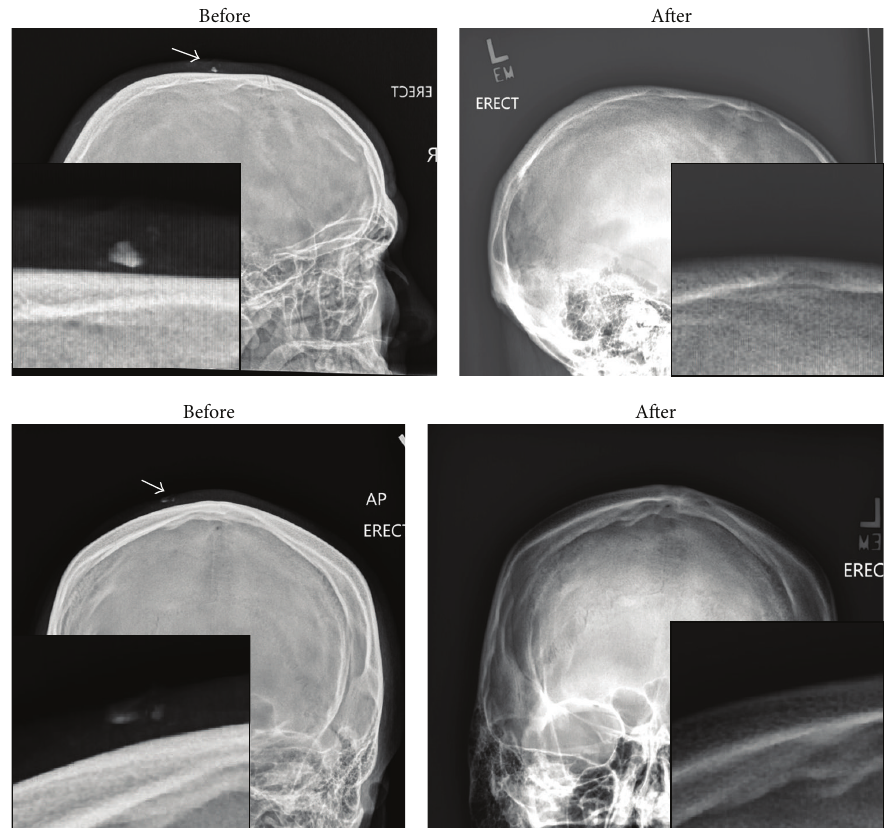
Figure 1: Before and after images of retained foreign bodies (fractured